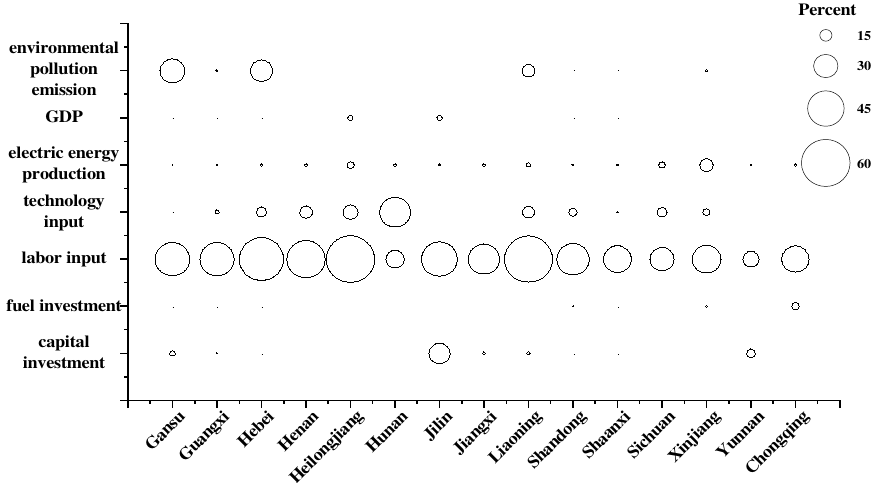
Figure 4. Percentage of improvement in inefficient provinces in the year 2010.